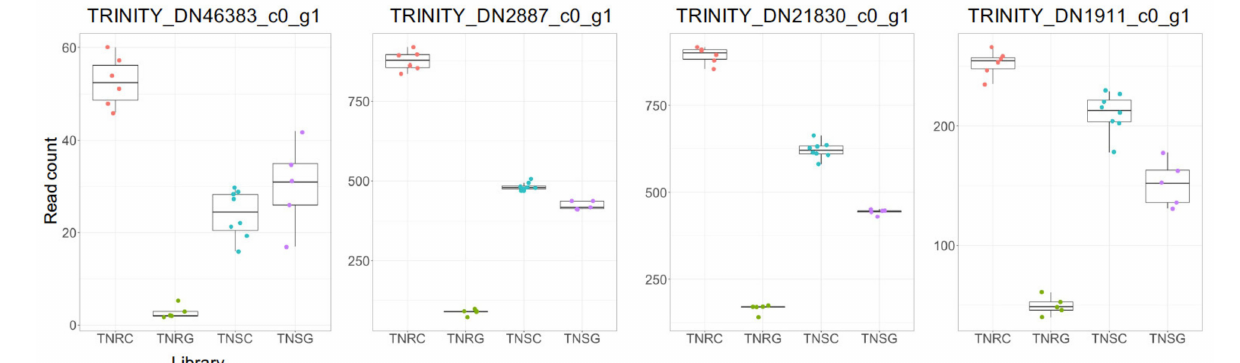
Figure 4. Read count summary of representative genes of downregulated genes in TNR but not in TNS after glyphosate treatment. These genes were selected from the genes listed in Table